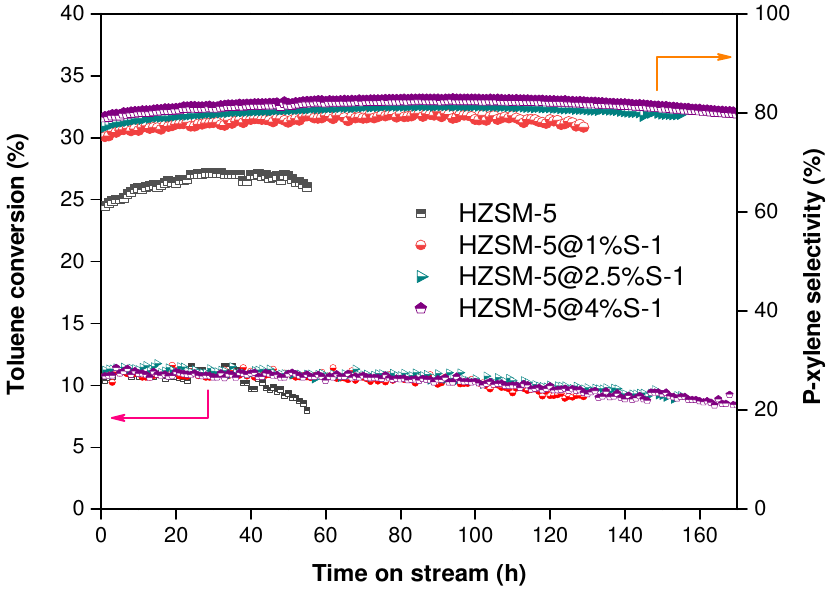
Figure 8. Long-term stability test of the parent HZSM-5 and HZSM-5@silicalite-1 catalysts. Reaction conditions: 0.2 g catalyst, 1 bar, 470 °C, WHSV = 8 h −1 , H 2 55 mL/min. The pink arrow and orange arrow represent toluene conversion and p -xylene selectivity, respectively.